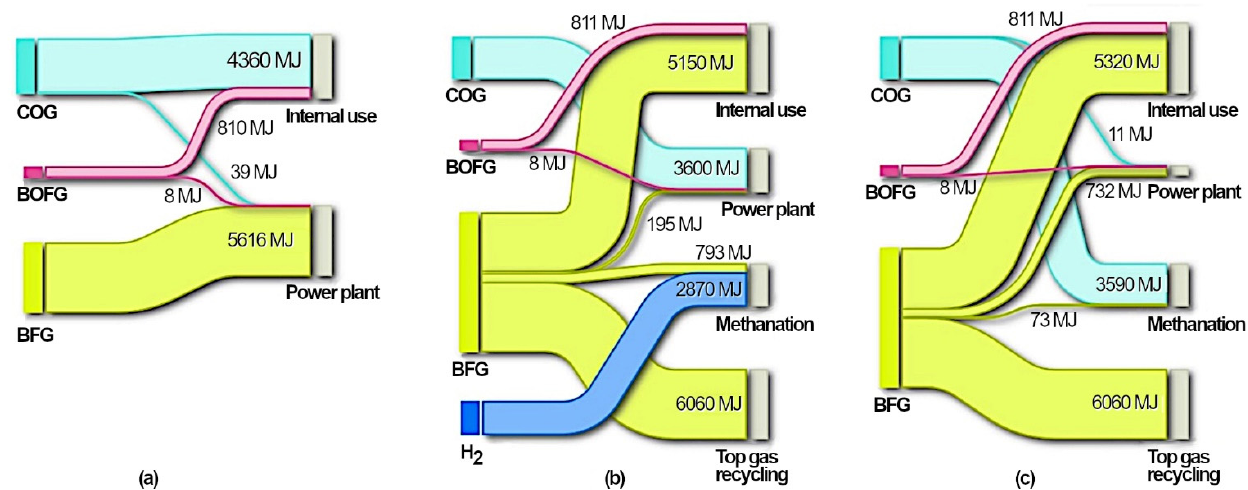
Figure 7. Sankey diagram of the change in the energy utilization inside the ironmaking plant of the energetic gases COG, BOFG, and BFG: ( a ) Case 0, ( b ) Case 1, and ( c ) Case 2.